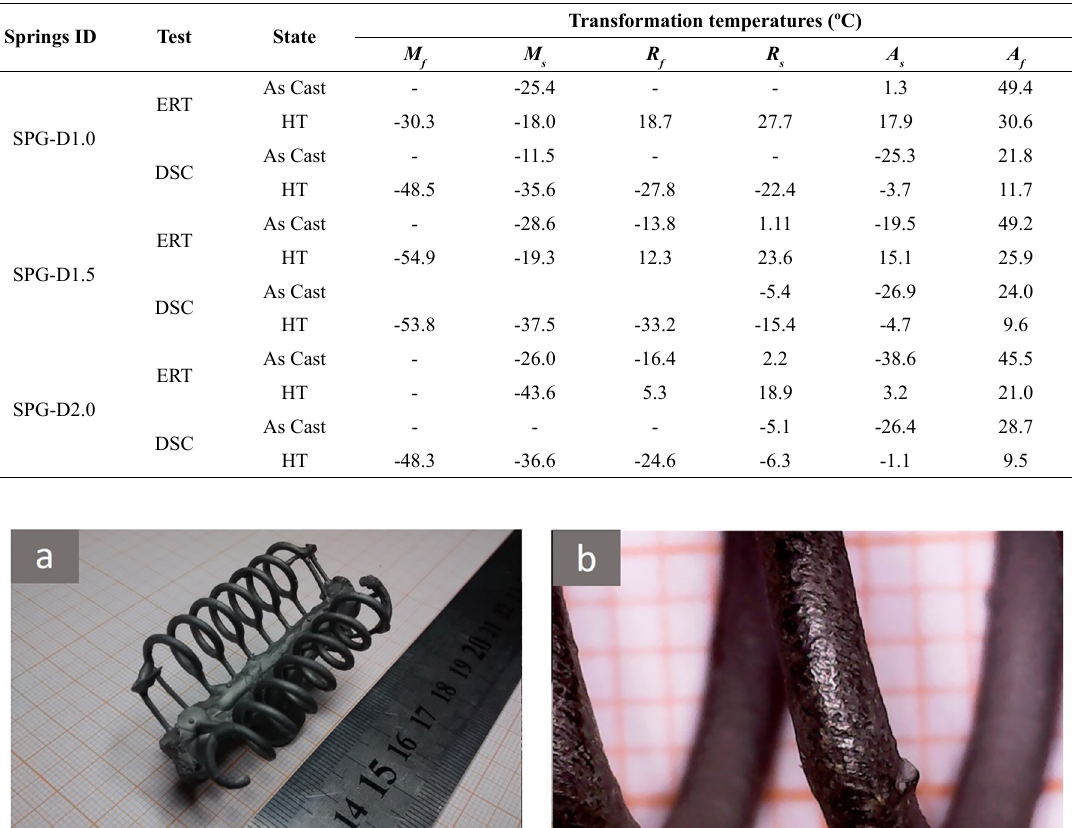
Table 2. Phase transformation temperatures of the as-cast and heat-treated Ni-Ti SMA springs by ERT and DSC techniques.